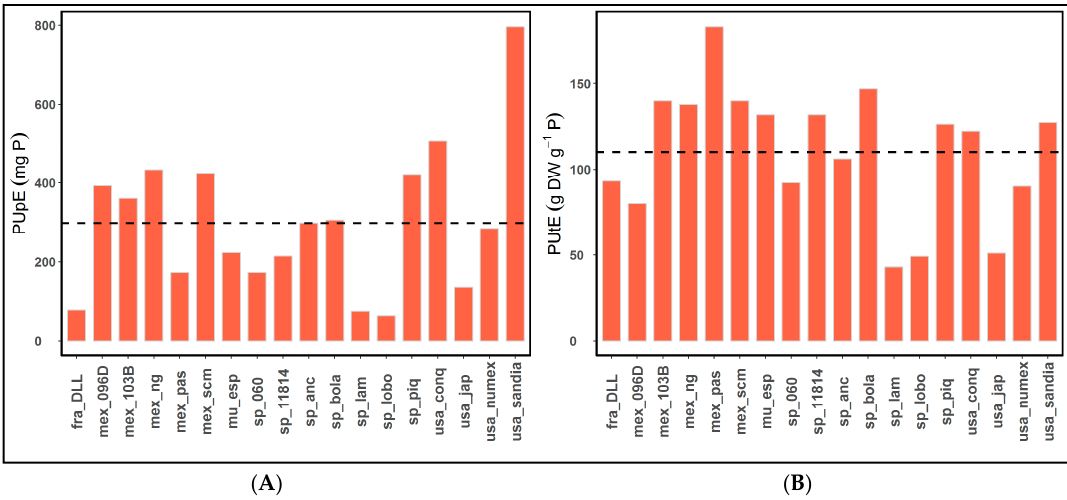
Figure 4. ( A ) Average P uptake efficiency (PUpE) and P utilization efficiency (PUtE) values for the 12 accessions studied in Trial 2 ( n = 6). ( B ) Black dashed line represents average value for the whole collection for both PUpE (298 mg P) and PUtE (110 g DW g − 1 P) parameters.